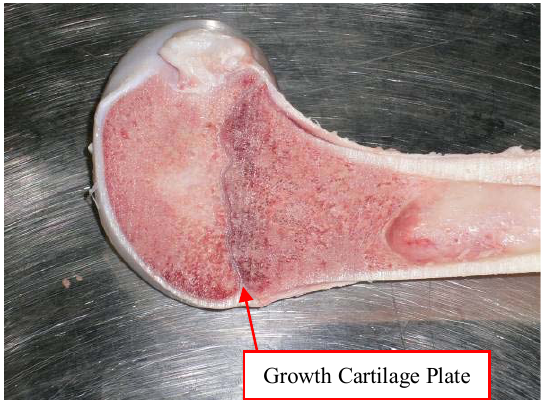
Fig. 8 Sagittal cross section of porcine distal femur. The growth cartilage plate divides trabecular bone.